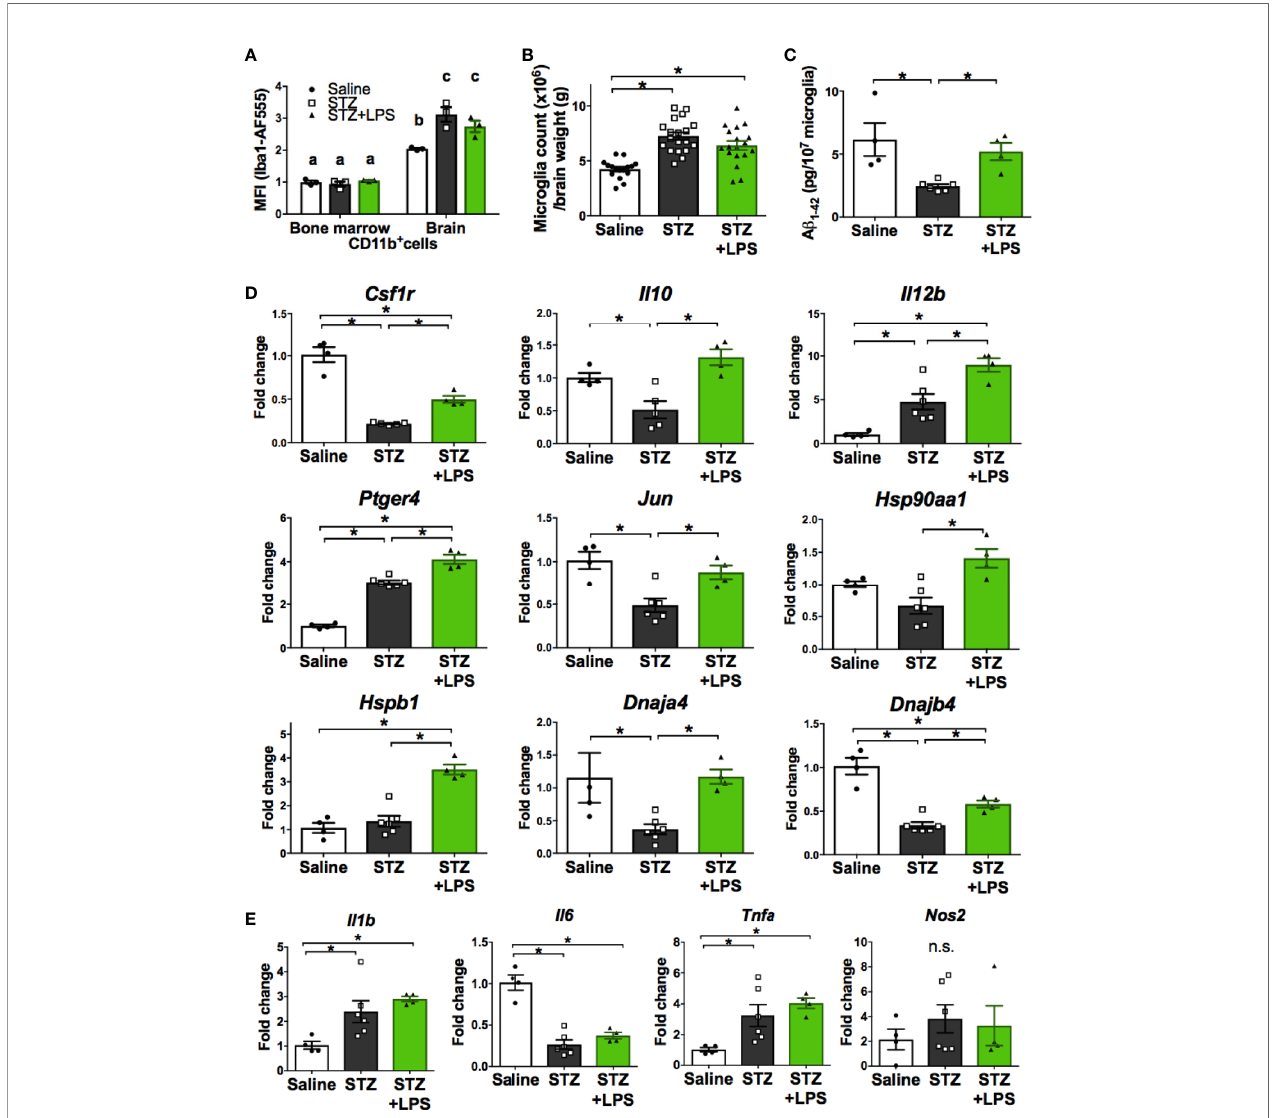
FIGURE 3 | Neuroprotective microglia are transformed through OAL. (A) High expression of Iba1 in isolated microglia (n = 3). (B) Number of isolated microglia (n = 17 – 19). (C) A b 1-42 levels in isolated microglia (n = 4 – 6). (D, E) Upregulation of neuroprotective genes and unchanged in fl ammatory genes in isolated microglia through OAL (n = 4 – 6). Means ± SE are presented. *p or a,b p < 0.05 for one-way ANOVA with Tukey ’ s multiple comparisons or two-way ANOVA with Sidak multiple comparisons. n.s., not signi fi cant. a,b,c p < 0.05 for two-way ANOVA with Sidak multiple comparisons. The different letters (the symbols of a, b, c) indicate statistically signi fi cant difference between groups in multiple comparison